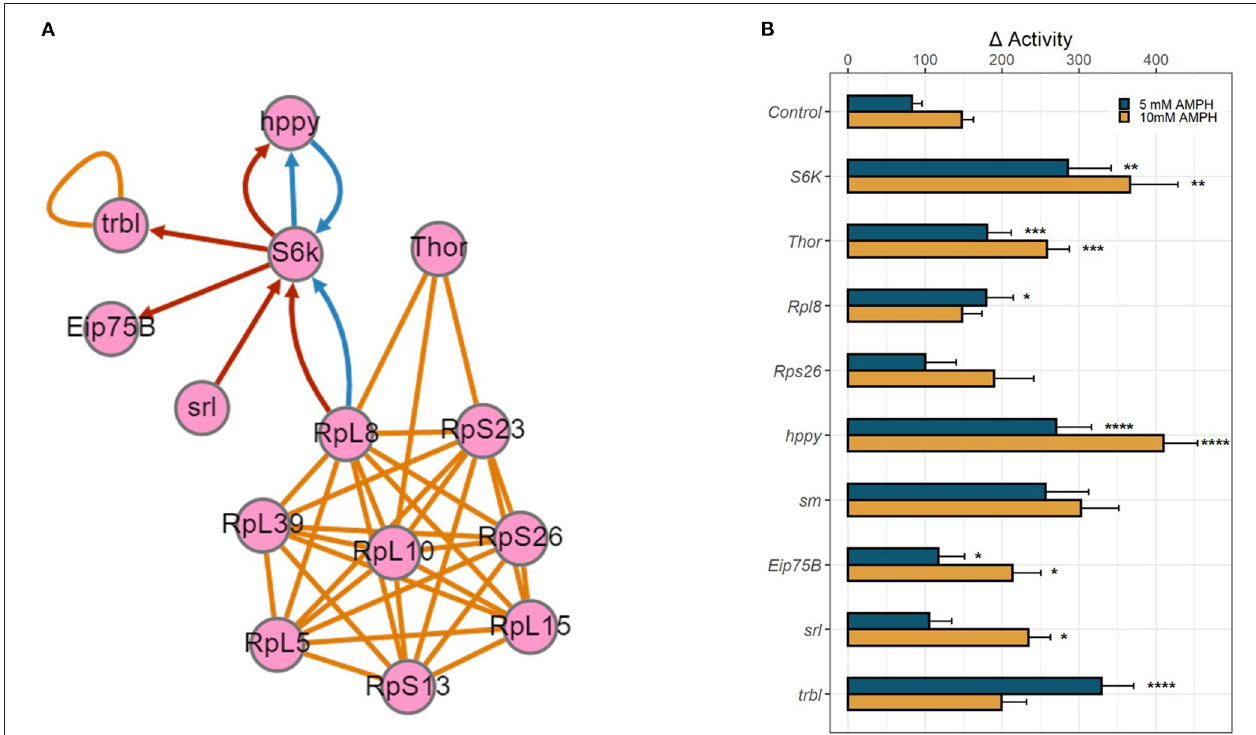
FIGURE 4 | Functional validation of candidate genes. (A) Gene network depicting physical and genetic interactions between candidate genes identified in RNA-seq and GWA analyses. Orange lines indicate reported physical interaction, blue arrows indicate enhancing genetic interaction, and red arrows indicate suppressing genetic interaction. Network generated using the esyN webtool. S6K and Thor encode direct targets of the MTOR signaling pathway, S6 Kinase and 4E-BP, which are known to interact with ribosomal proteins to modulate mRNA translation. hppy encodes MAP4K3 which regulates the phosphorylation of S6K and 4E-BP. Eip75B , srl , and trbl all encode modulators of insulin-mTOR S6K signaling. (B) RNAi-mediated knockdown of candidate genes was targeted to dopamine neurons using TH-GAL4. Bar graphs depict change in activity in response to 5mM AMPH (blue) or 10mM AMPH (yellow). Error bars indicate SEM. Statistical significance was determined by Kruskal-Wallis ANOVA ( p < 2e-16). Asterisks indicate pairwise significance compared to genotype control after AMPH treatment, as determined by post-hoc Dunn’s Test with a Benjamini-Hochberg correction for multiple testing, **** p .adj < 0.0001, *** p .adj < 0.001, ** p .adj < 0.01, * p .adj <